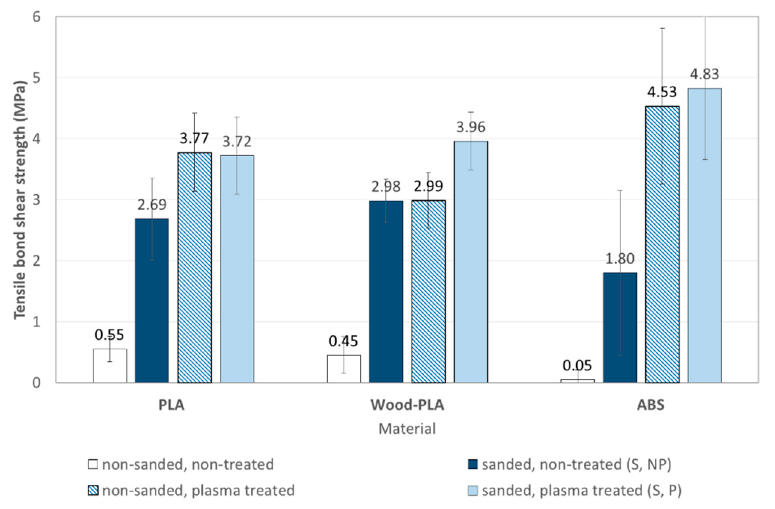
Figure 9. Bond tensile-shear strength of sanded samples from PLA, Wood-PLA and ABS, non-treated and treated with plasma.